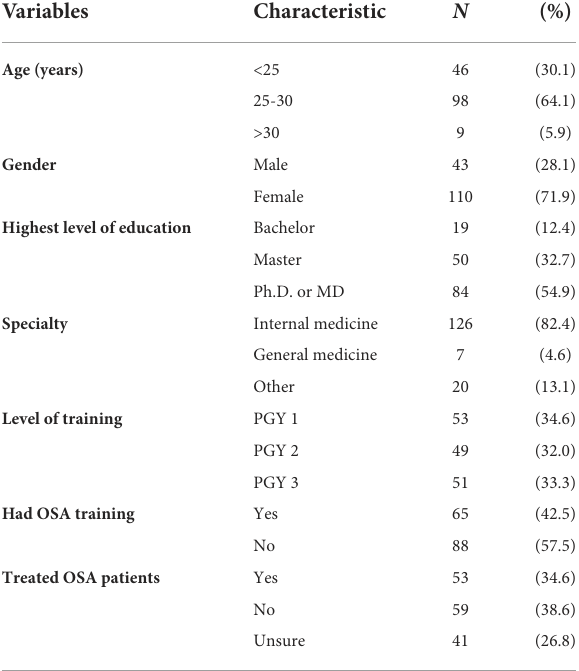
TABLE 1 Demographic characteristics of the participants ( N =